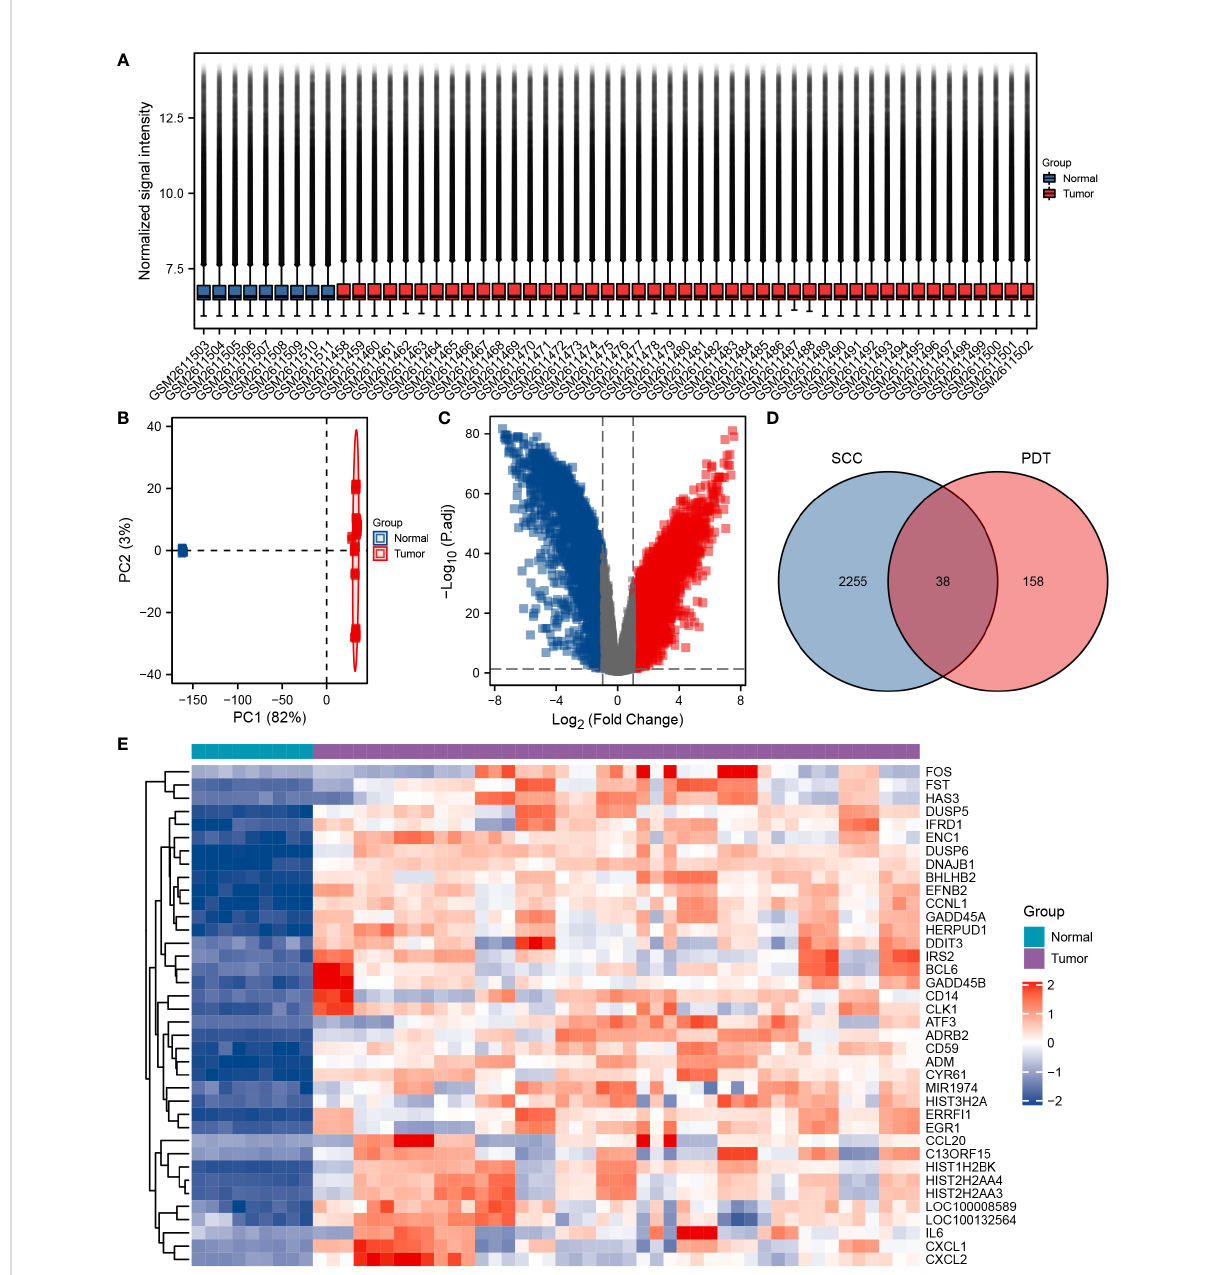
FIGURE 1 Identi fi cation of differentially expressed cSCC-PDT-related genes. (A) Box plot of 54 samples of GSE98767 after log 2 standardization original counts. (B) Principal component analysis (PCA) analysis of tumor and a normal group of GSE98767. (C) Volcano plot of DEGs in cSCC and normal samples of GSE98767. The red square dots represented upregulated genes, while the green square dots represented downregulated genes (cutoff: adj. P-value<0.05 and |Log 2 (Fold Change) |>1). (D) Venn diagram showing the 38 cSCC-PDT-related genes (the intersection of the cSCC and PDT). (E) Heatmap displaying the expression level of 38 cSCC-PDT-related genes in GSE